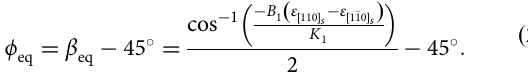
Because the experimental realization of the bound values of ± 45° has been observed at E = ± 4 kV cm − 1 (Fig. 2c), it is anticipated that the Fe 1 − x Ga x fi lm experiences a minimum strain (cid:6) ε ¼ (cid:6) K = B at E = − 4 kV cm − 1 anisotropy of ε ½ ½ 1 (cid:1) 10 (cid:7) 110 (cid:7) s 1 1 s (cid:6) ε be extracted with knowledge of the strain, ε ½ at E = ½ 1 (cid:1) 10 (cid:7) (cid:4) 110 (cid:7) s s (cid:6) c ± 4 kV cm − 1 and the pre-factor c 11 12